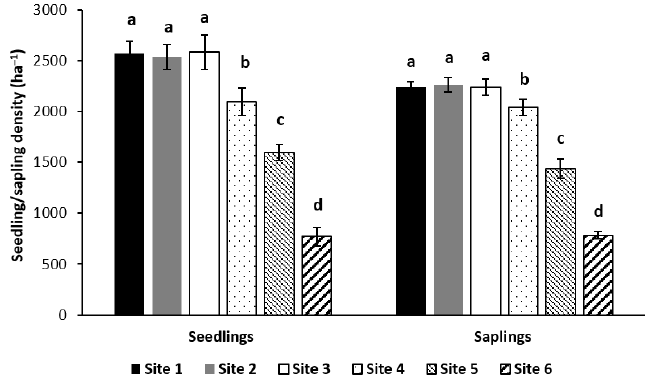
Figure 2. Seedling and sapling densities of forests at six study sites. Error bars show standard deviations. Different letters indicate significant differences among the sites by Duncan’s multiple range tests at p < 0.05.